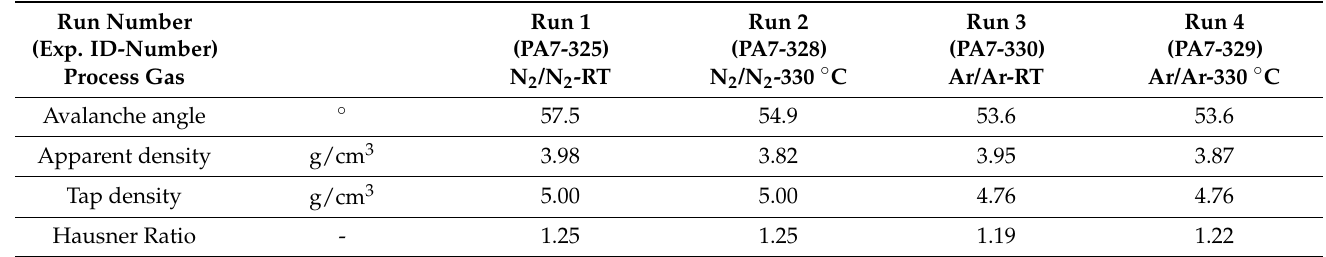
Table 7. Powder properties (powder fraction 20–63 µ m).